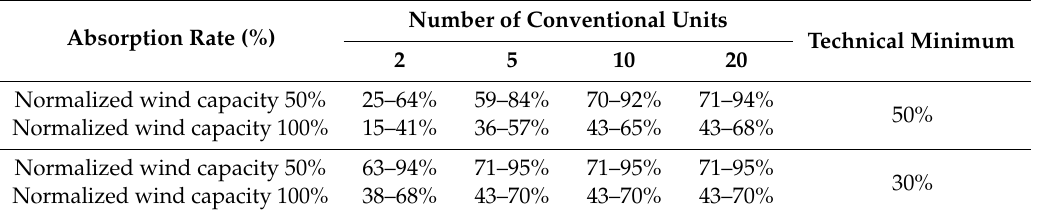
Table 9. Extreme values of the absorption rate (%) detected for di ff erent cases of conventional systems flexibility (number of units 2, 5, 10 and 20 and technical minimums 30% and